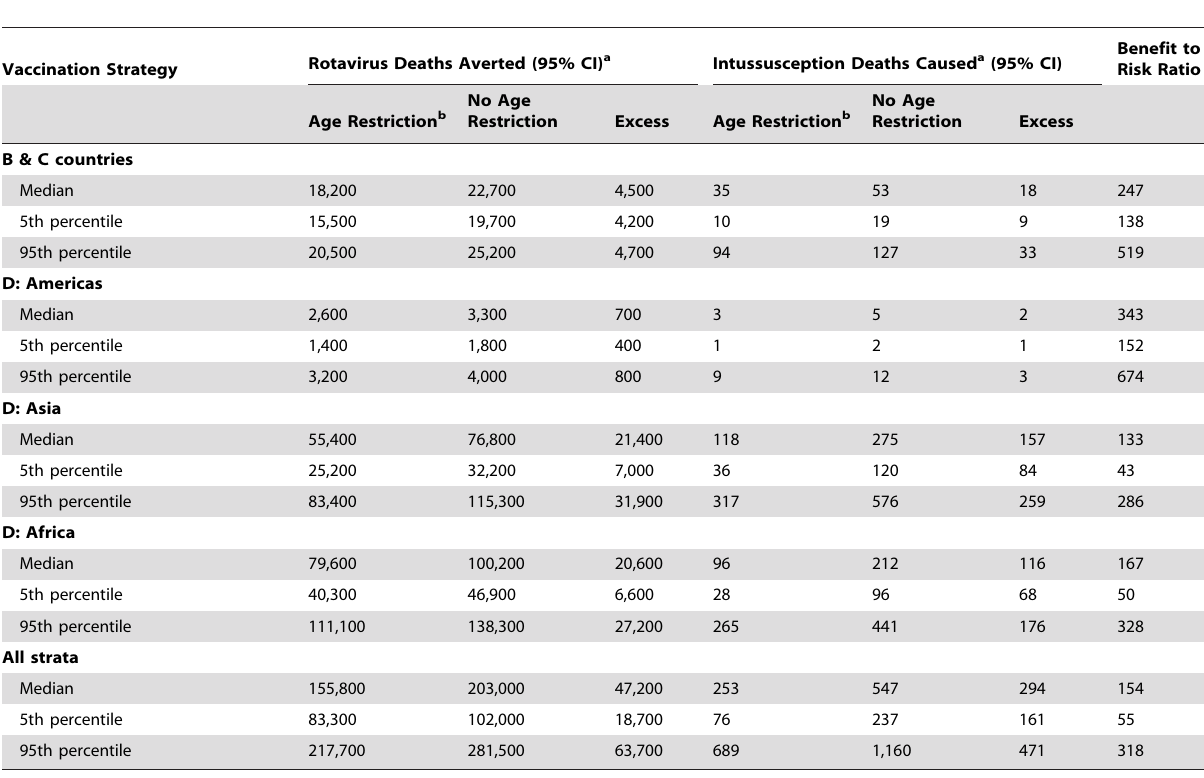
Table 4. Rotavirus deaths averted versus excess intussusception deaths caused under age-restricted and age-unrestricted rotavirus vaccination strategies, by WHO mortality group and